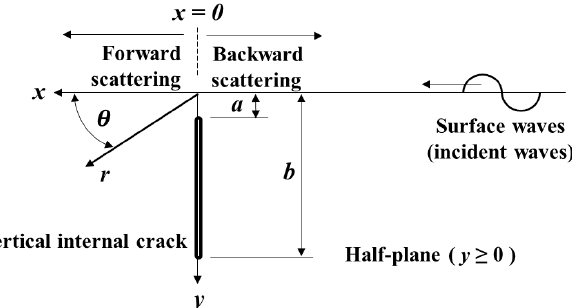
Figure 1. Illustration of subsurface crack on the two-dimensional 𝑥 −𝑦 half-plane. 𝑎 is the distance between the ground and the top of the crack tip, 𝑏 is the distance between the ground and the bottom of the crack tip and 𝑟 and 𝜃 are components of the polar coordinate. The image shows the directions of the incident waves and scattered waves influenced by different 𝑎 and 𝑏 distances.